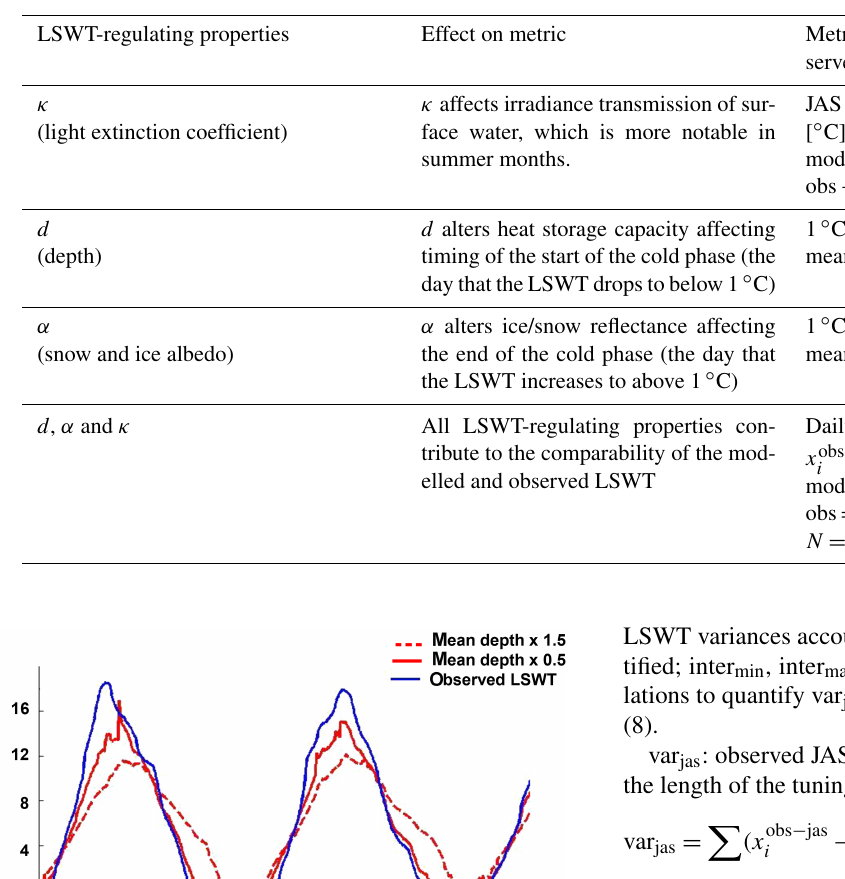
Table 3. Relationship between the lake surface water temperature (LSWT)-regulating properties and metrics, showing the equations for determining the daily mean absolute difference (MAD) and the July–August–September (JAS) LSWT mean difference. Units are given in square brackets.